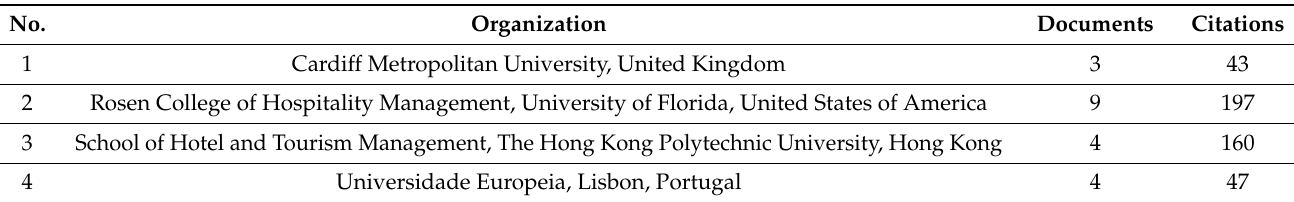
Table 6. Top organizations in the co-authorship of organizations analysis.